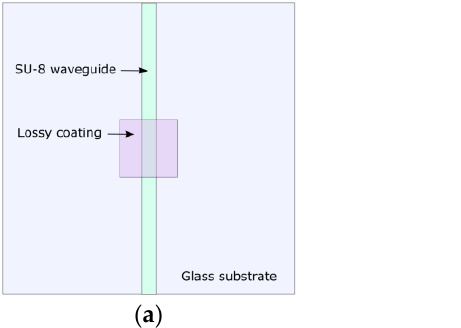
Figure 1. Integrated LMR sensor design: ( a ) top view, ( b ) cross-sectional view.